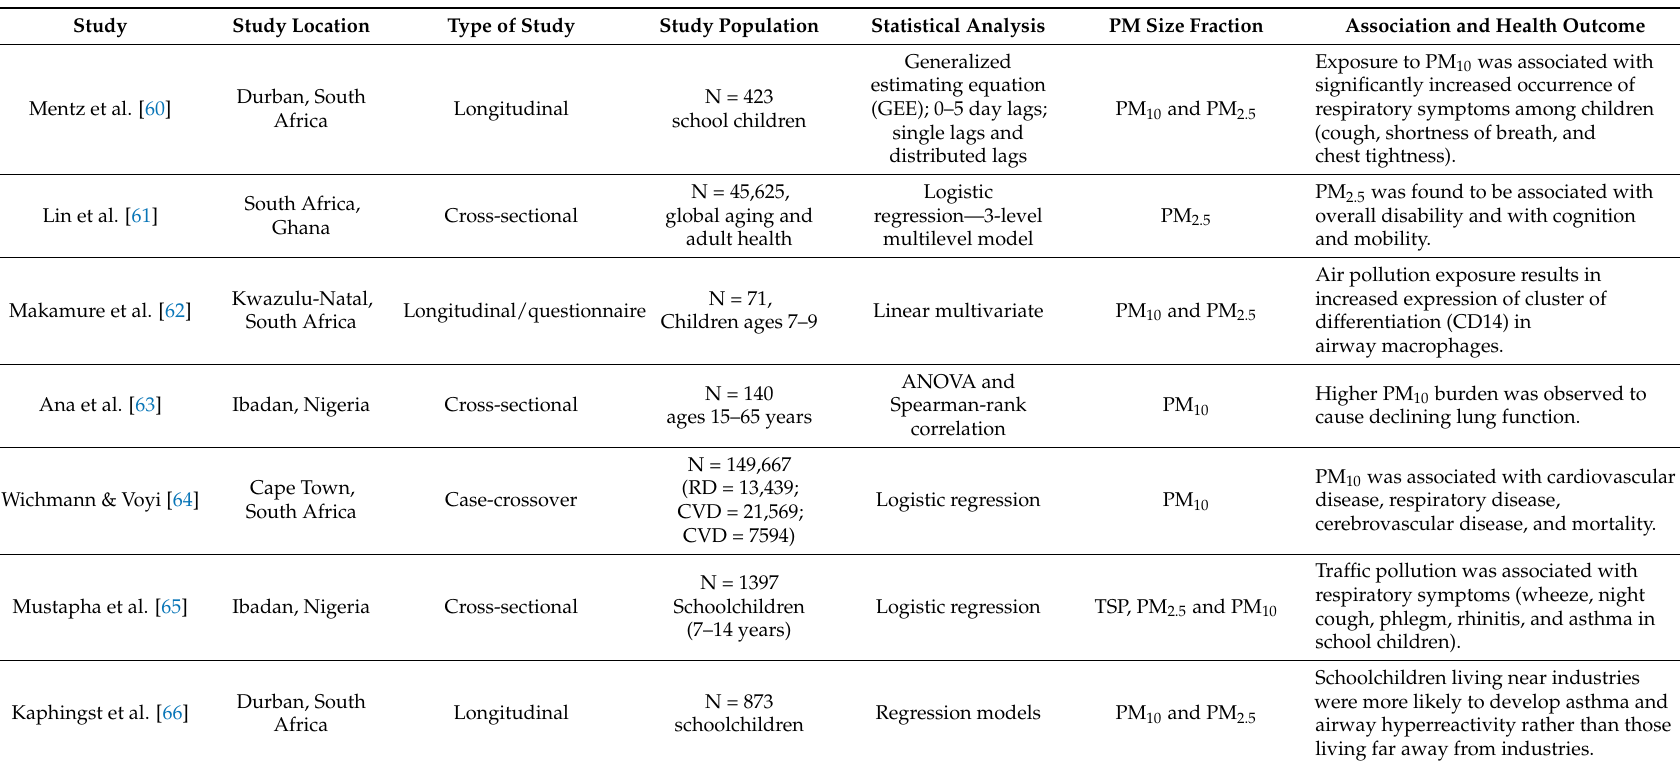
Table 1. Summary of epidemiological and toxicological studies conducted in Africa on health effects of exposure to a mass concentration of ambient particulate matter size fraction. Particulate matter: ambient PM 2.5 (particles less than 2.5 µ m in diameter), ambient PM 10 (particles less than 10 µ m in diameter), TSP (total suspended